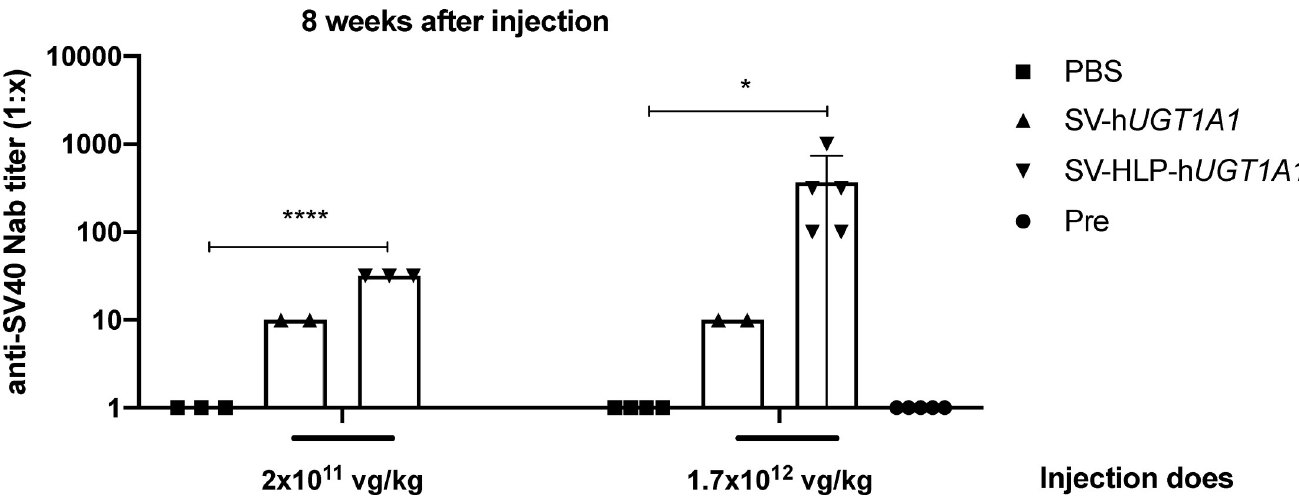
Fig 5. Intravenous injection does induce neutralizing antibodies towards rSV40. 60-day-old Ugt1a -/- mice were treated with a lower dose of 2x10 11 vg/kg of rSV- h UGT1A1 vector (n = 3), or rSV-HLP-h UGT1A1 (n = 3), and a higher dose of 1.7x10 12 vg/kg of rSV-h UGT1A1 vector (n = 4), or rSV-HLP-h UGT1A1 (n = 5) via tail vein injection. Serum samples at 8 weeks after vector administration were tested for presence of NAbs towards rSV40 vectors using an in vitro transduction assay. NAbs titers are expressed as the highest serum dilution that inhibited AAV transduction by � 50% compared with the control without serum. Pre represents before vector injection. Data represent the mean ± SD. Statistical significance was determined by Ordinary one-way ANOVA with Dunnett’s multiple comparison test.